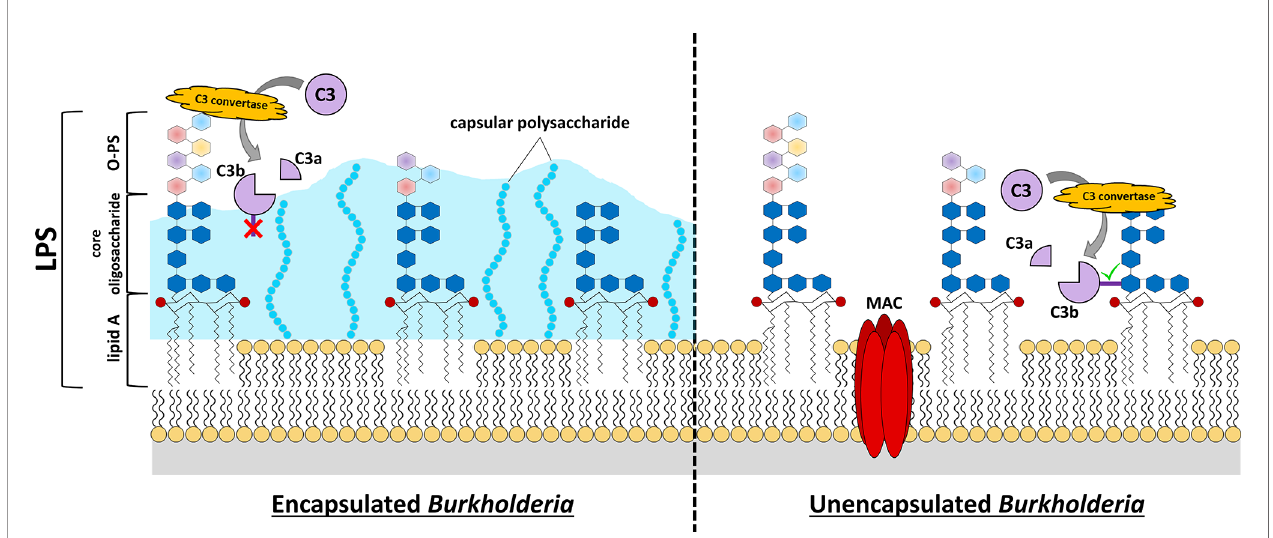
FIGURE 1 | Burkholderia cell surface structures involved in evading complement-mediated killing. C3 convertase-mediated cleavage of C3 into C3a and C3b reveals an unstable thioester bond on C3b (dark purple rectangle). If this protein is not generated close to the cell surface or other receptive structures, the thioester bond is quickly hydrolyzed, and the protein loses its enzymatic activity or its ability to attach as an opsonin to the surface (red “ X ” , C3b in left panel). Many pathogenic Burkholderia express capsular polysaccharide that extends quite distant to the cell membrane. This can provide protection from complement activation and opsonization because its structure is not conducive to C3b-binding and, if binding does occur, the bound C3b is relatively distant from the bacterial cell membrane to allow MAC formation. While the lipid A and core oligosaccharide structures of Burkholderia LPS are fairly conserved, there is considerable variation in the O-PS of these bacteria (multi-colored hexagons). Analysis of LPS structures of representative Burkholderia spp. have demonstrated that these organisms harbor 4-amino-4- deoxy- L -arabinose (Ara4N) modi fi cations on the phosphate groups (red circles) of the lipid A disaccharide backbone. The expression of elongated O-PS moieties stretching away from the cell surface can protect against complement-mediated killing by preventing C3 convertase formation close to the cell surface, and thus prevent insertion of a MAC complex in the cell membrane. If C3 convertase forms close to the cell membrane (e.g. LPS core moieties, etc.), the exposed thioester of C3b quickly binds nearby hydroxyl or amino groups (green check mark, C3b in right panel). Complement opsonins that bind distant from the cell surface can promote killing by opsonophagocytosis if they can be recognized by phagocytic cells, however activation/binding near the surface promotes direct killing via formation of MAC and bacterial